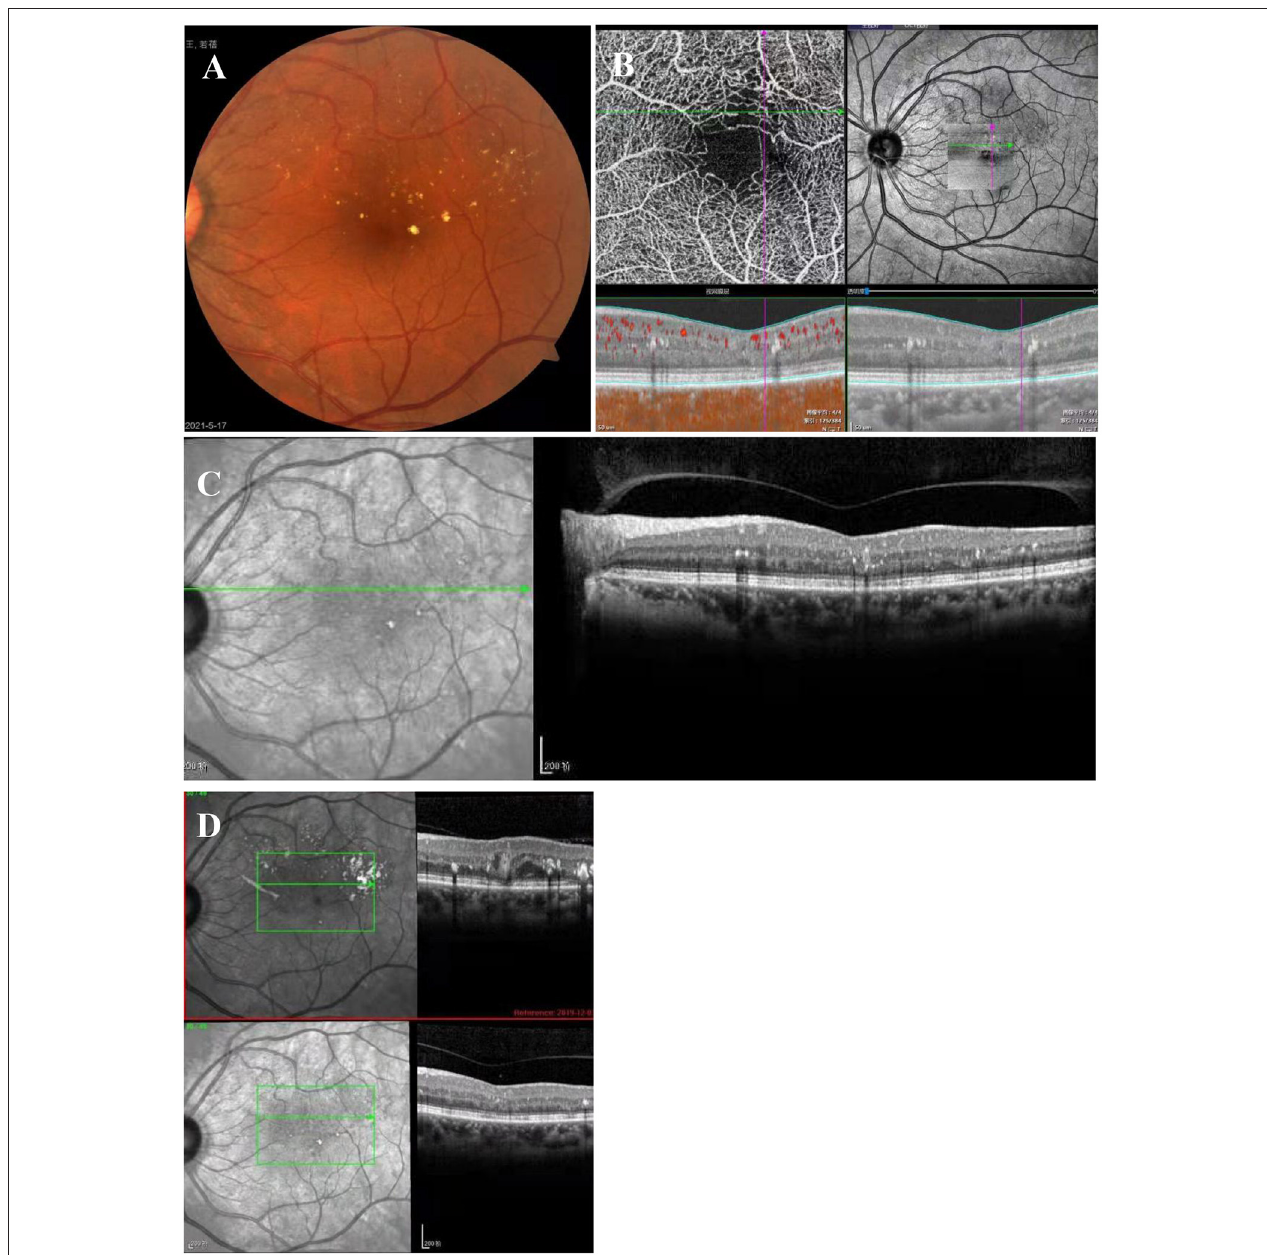
FIGURE 4 | Twenty-four months after MPL treatment. (A) Exudates are scattered above the macular area. (B) OCT-A shows sparse vessels in the upper arch ring and that the tumor-like dilatation had disappeared. (C) OCT shows that the tumor-like structure had disappeared, and there are a few punctate hyperreflections between the layers. (D) In the OCT comparison chart, the tumor-like structure had